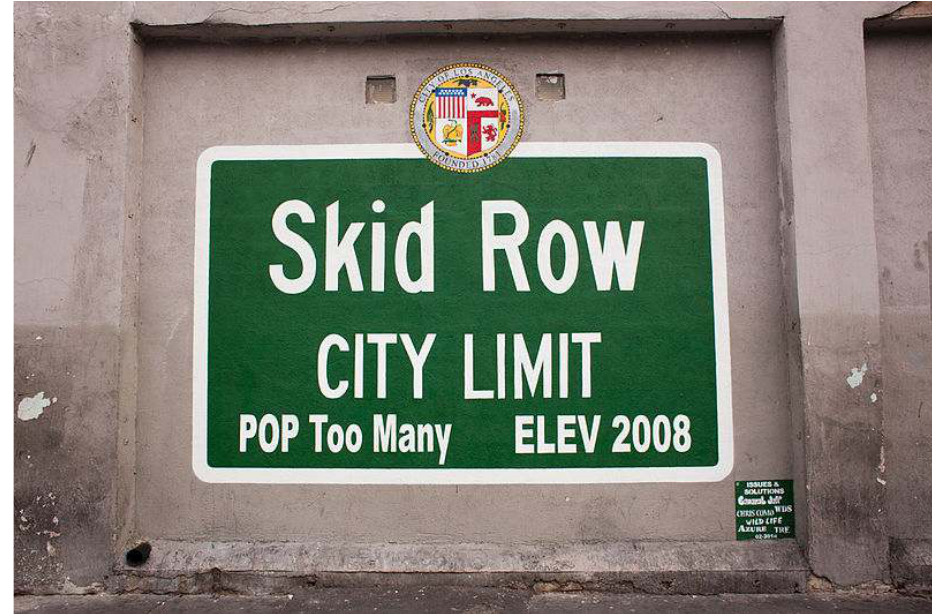
Figure 1. Los Angeles. June